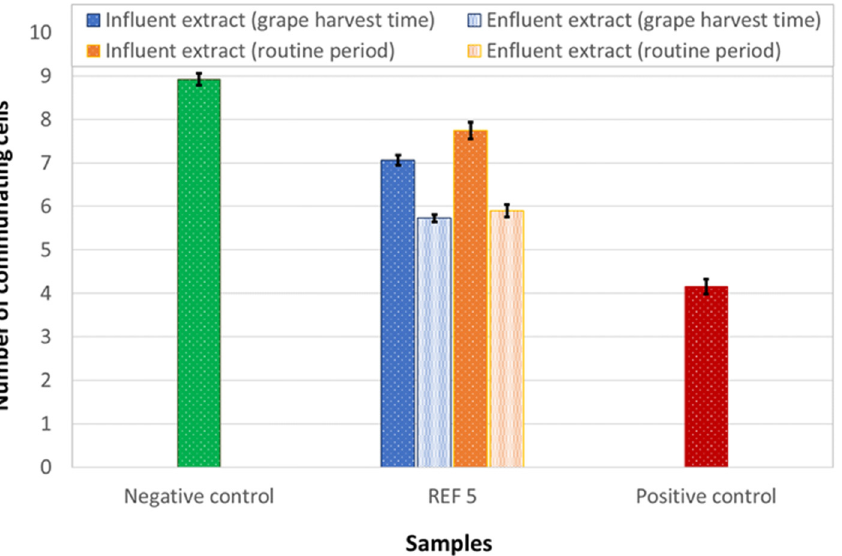
Figure 10. Gap junction Intercellular communication was assessed in IAR203 hepatic cells exposed to influent and effluent wastewaters. The error bars show the standard error of mean.